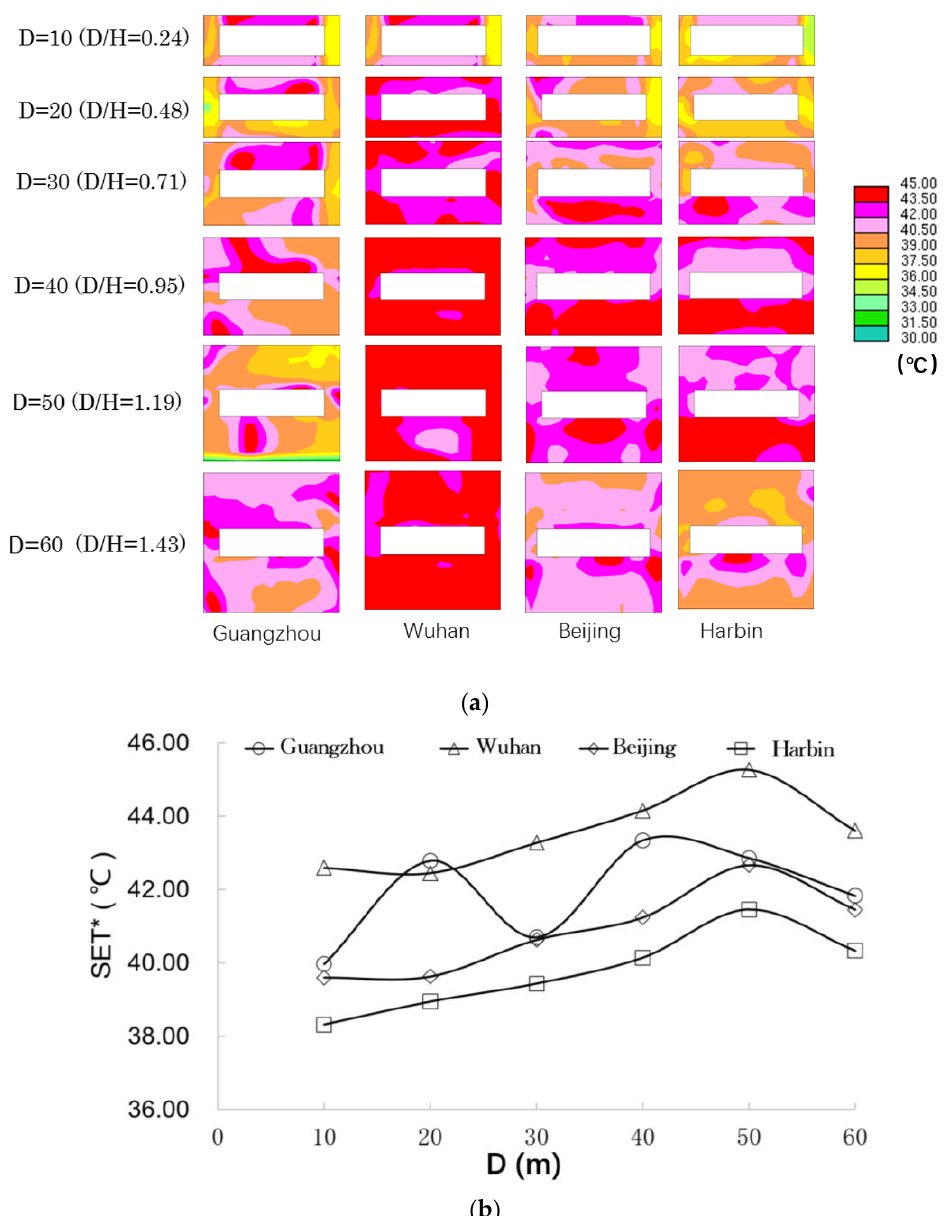
Figure 11. Results of SET*. ( a ) The distribution of SET* at 1.5 m. ( b ) Relationship between building distance and mean SET.